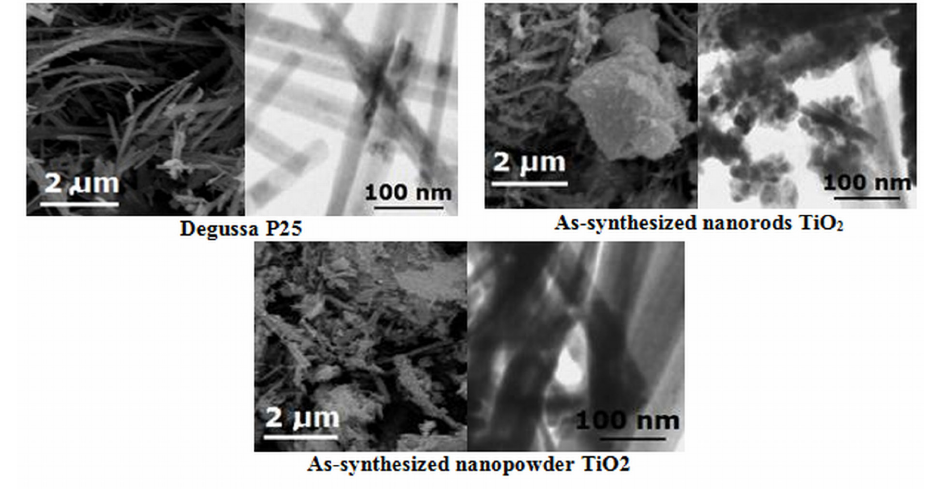
Figure 11: SEM (left) and TEM (right) of samples prepared using different TiO2